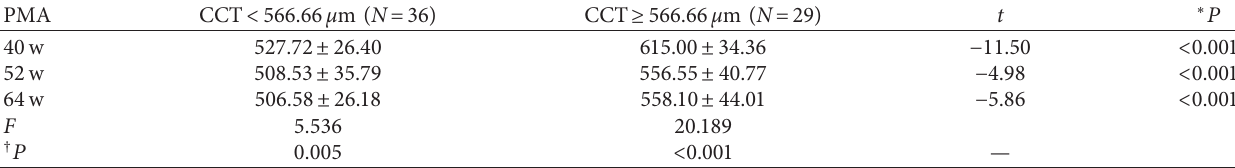
Table 7: CCT variation trend at 40 w, 52w, and 64w of PMA.